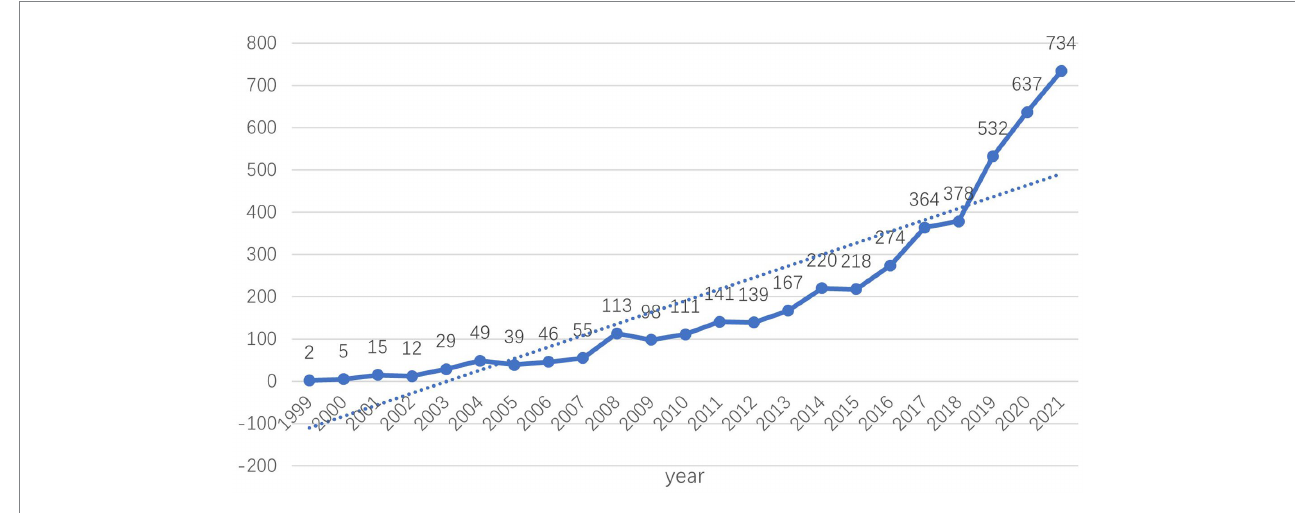
FIGURE 1 Trends in annual publications in positive psychology